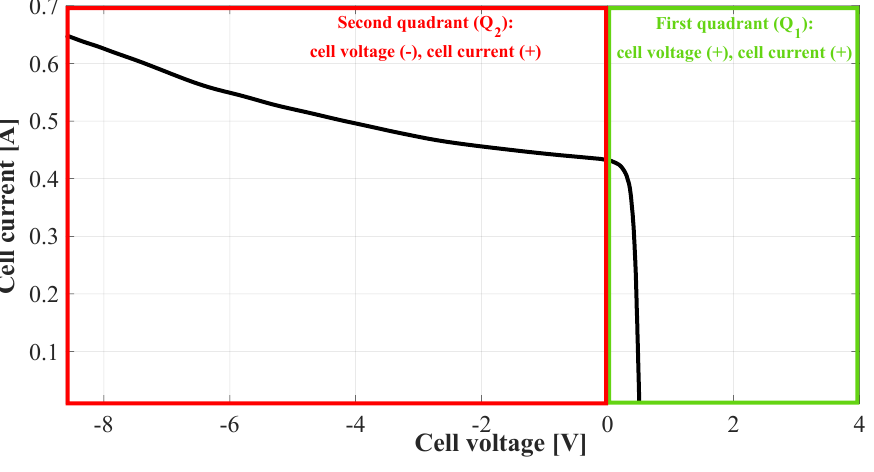
Figure 1. The electrical characteristic of a PV